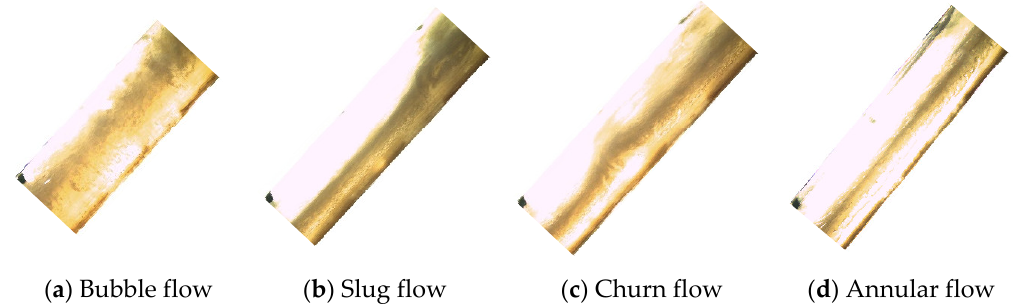
Figure 4. Flow pattern observed in the experiment at an inclination angle of 60°.